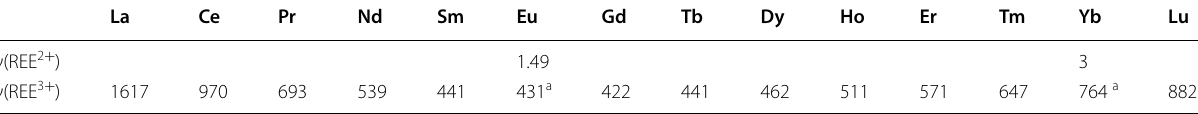
All coefficients apply to REE 3 + , except for Eu 2 + and Yb 2 + , which have also been considered. Given the oxygen fugacity range, Ce 4 + has not been considered here a For Eu 3 + and Yb 3 + , activity coefficients have been interpolated from other REE 3 + values